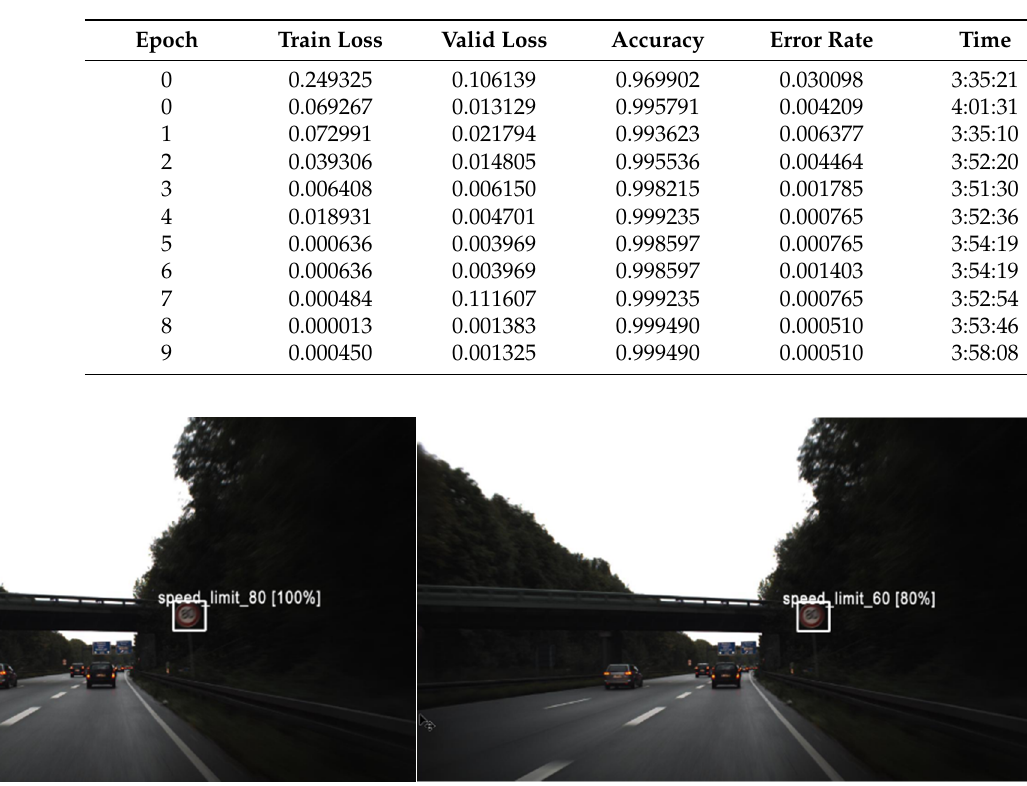
Figure 18. Comparing the performance of one of the wrong diagnoses by model DenseNet 169 and DenseNet 201 , which was correctly diagnosed by model DenseNet 121.